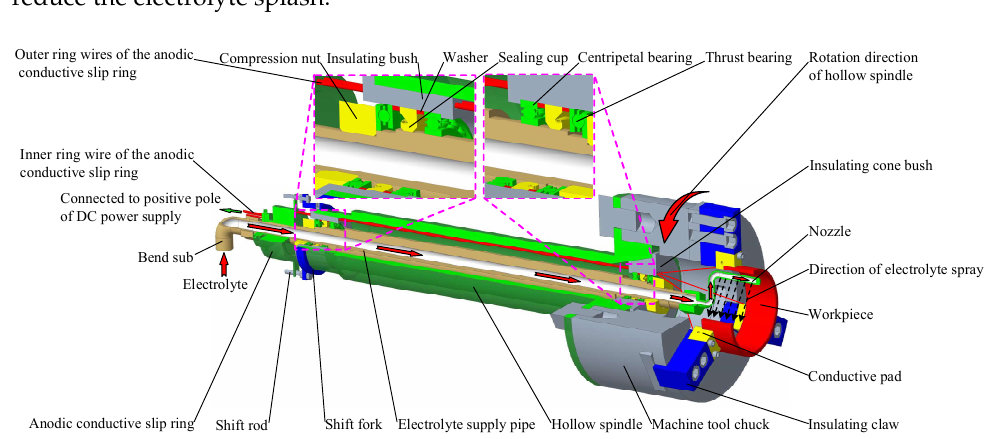
Figure 4. Schematic diagram of the workpiece clamping and rotating device.